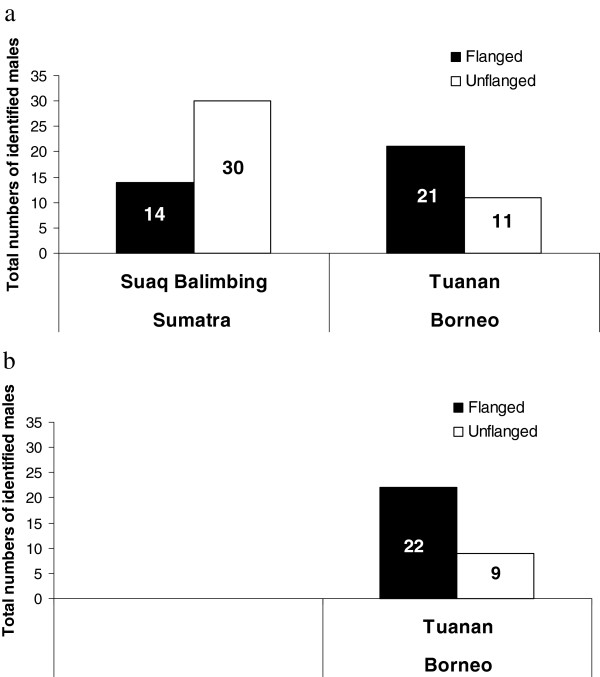
Total number of identified individuals. (a) The total number of identified flanged males (black bars) in Suaq Balimbing and Tuanan, as compared with the total number of unflanged males at the same sites (white bars), based on field identifications. (b) The total number of genetically identified flanged (black bar) and unflanged (white bar) males, for Tuanan only (unknowns genetically identified as new individuals are not included).